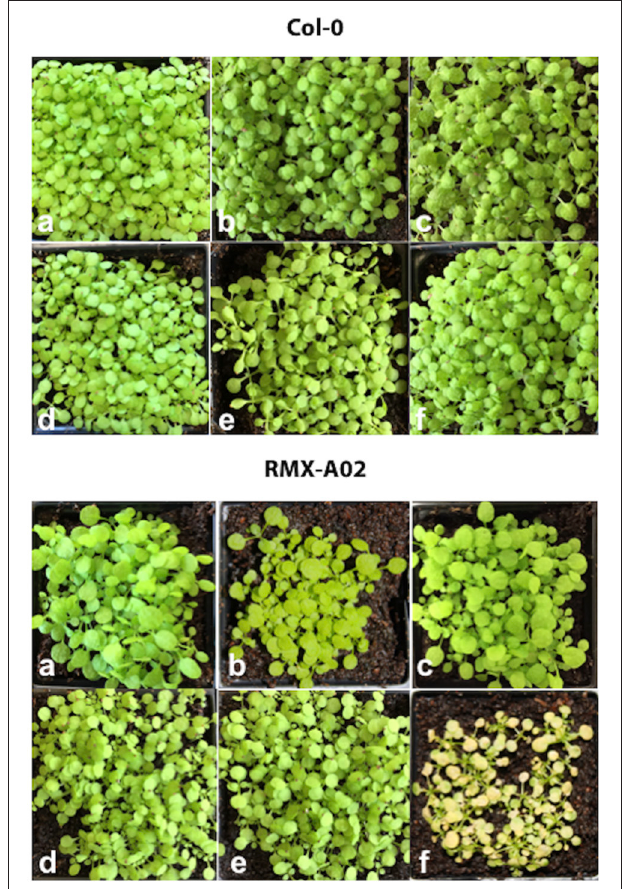
FIGURE 3 | Activation of HAC1 Cala2 induces cell death in transformed RMX-A02. Genes under the control of a dexamethasone (Dex)-activated promoter were transformed into Arabidopsis accessions Col-0 and RMX-A02 and T 3 plants were treated with 30 µ M Dex. (a) , non-transgenic, (b) , transgenic with S-HAC1 Cala2 , (c) , transgenic with s-hac1 Cala2 , (d) , transgenic with s-hac1 Noks 1 , (e) , transgenic with hac1 Noks 1 , (f) , transgenic with HAC1 Cala2 . Lines that carry HAC1 Cala2 became chlorotic 3 days after